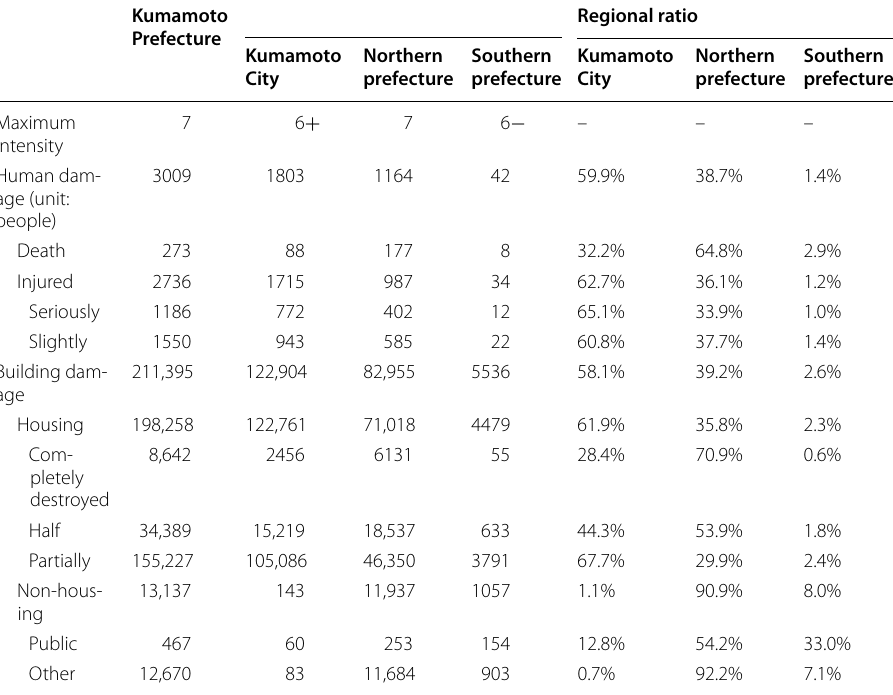
“Information on the 2016 Kumamoto Earthquake,” Japan Meteorological Agency website. “Damage from the Kumamoto Earthquake [Report 326],” Kumamoto Prefecture